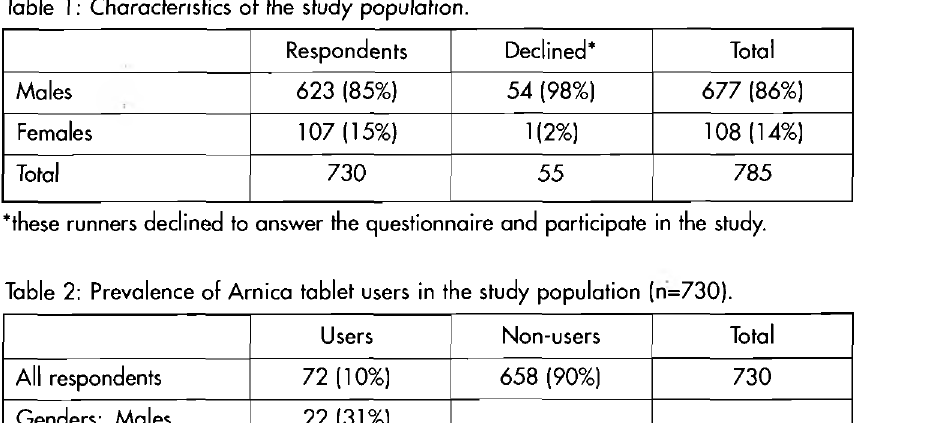
Table 2: Prevalence of Arnica tablet users in the study population (n=730).